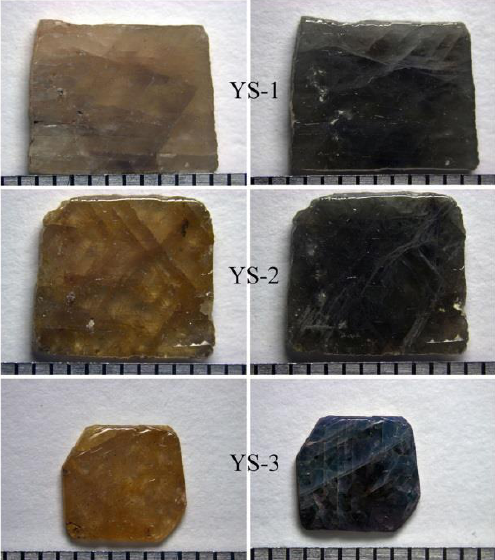
Figure 2. Yellow sapphire slices before and after reduction annealing. Left, before annealing; right, after annealing.